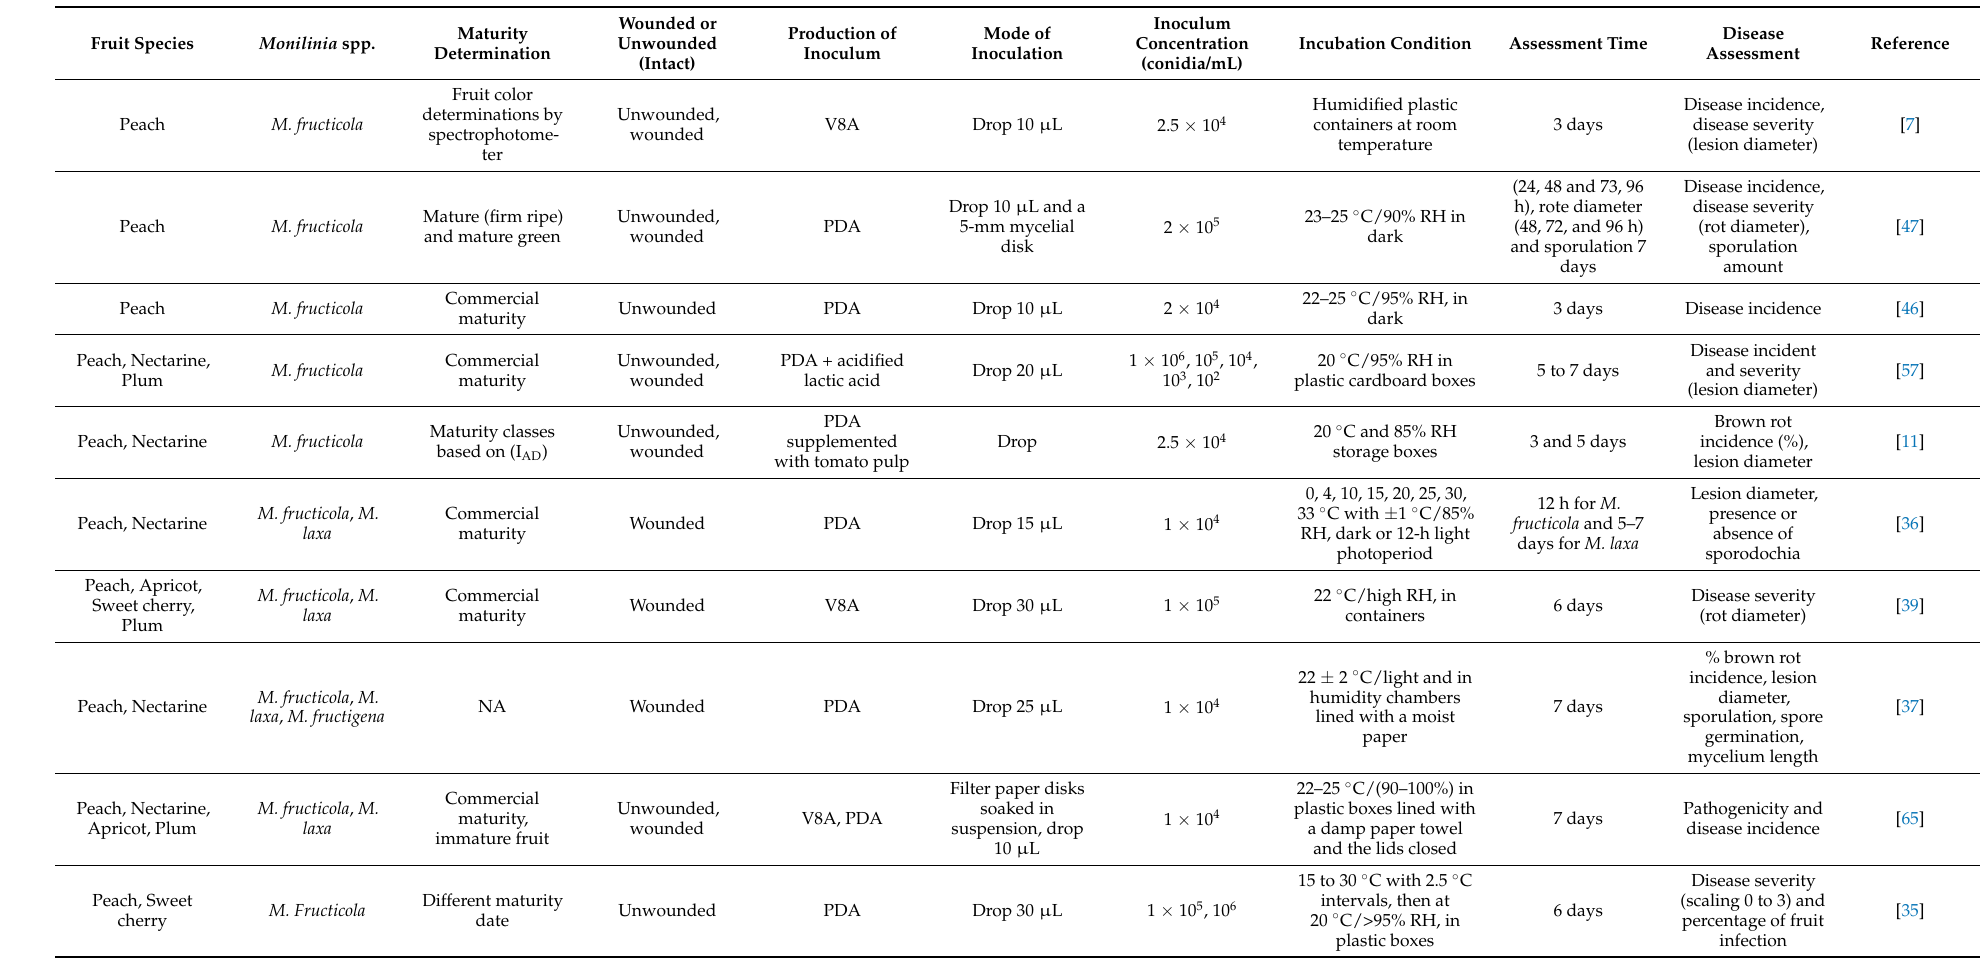
Table 1. Phenotyping protocols for evaluating brown rot disease susceptibility in stone